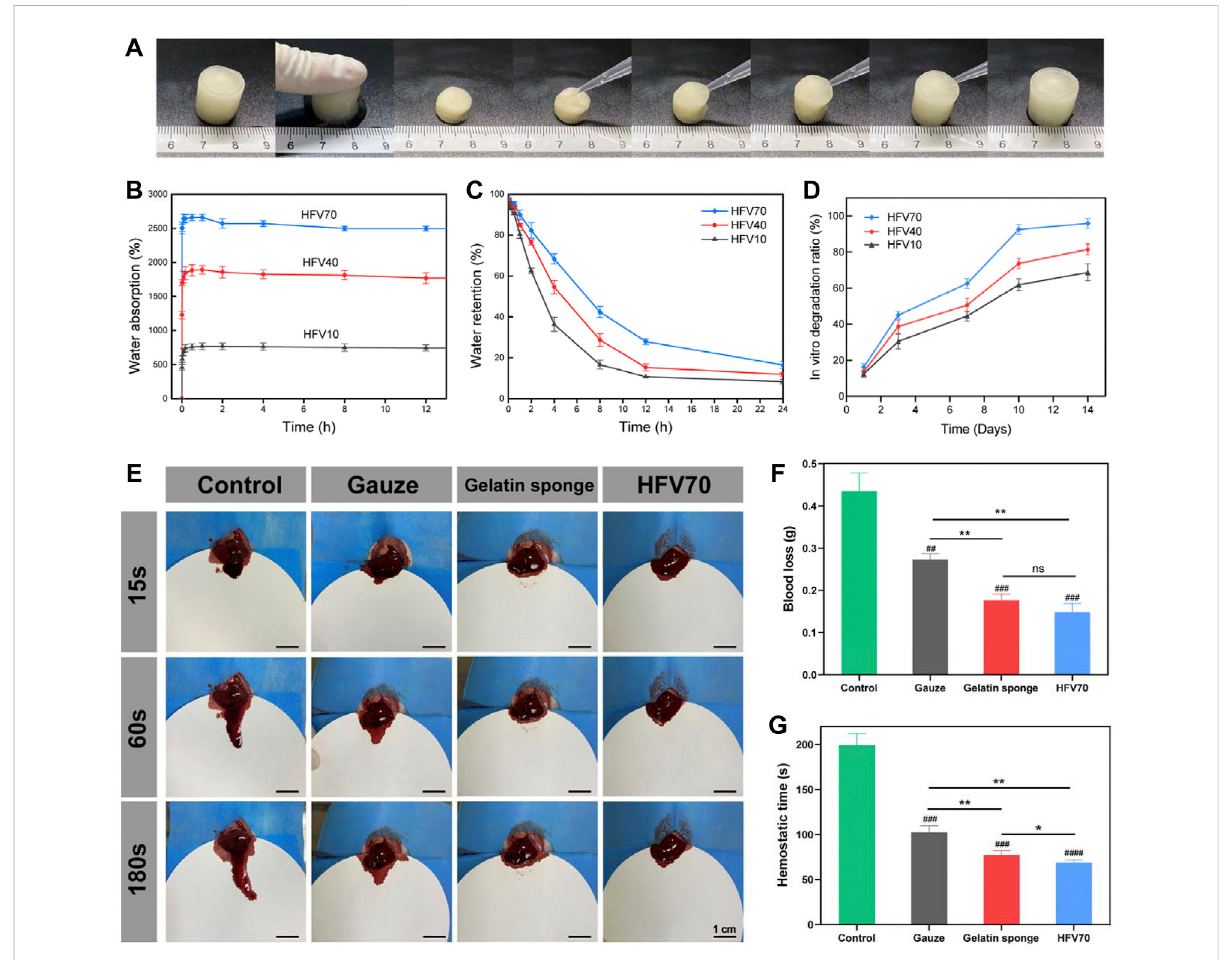
FIGURE 4 Shape memory performance, water absorption and retention test, and hemostasis in the normal rat liver perforation wound model. (A) Macro photographs of the water-triggered shape recovery of HFV70. (B) Water absorption of HFVs. (C) Water retention of HFVs. (D) Dependence of the in vitro degradation ratio of HFVs soaked in PBS on soaking time. (E) Photographs of the hemostatic effect of the gauze, gelatin sponge, and HFV70. (F) Blood loss from the liver incision. (G) Hemostatic time of different treatment groups. * p < 0.05; ** p < 0.01; *** p < 0.001; **** p < 0.0001, in comparison with the control